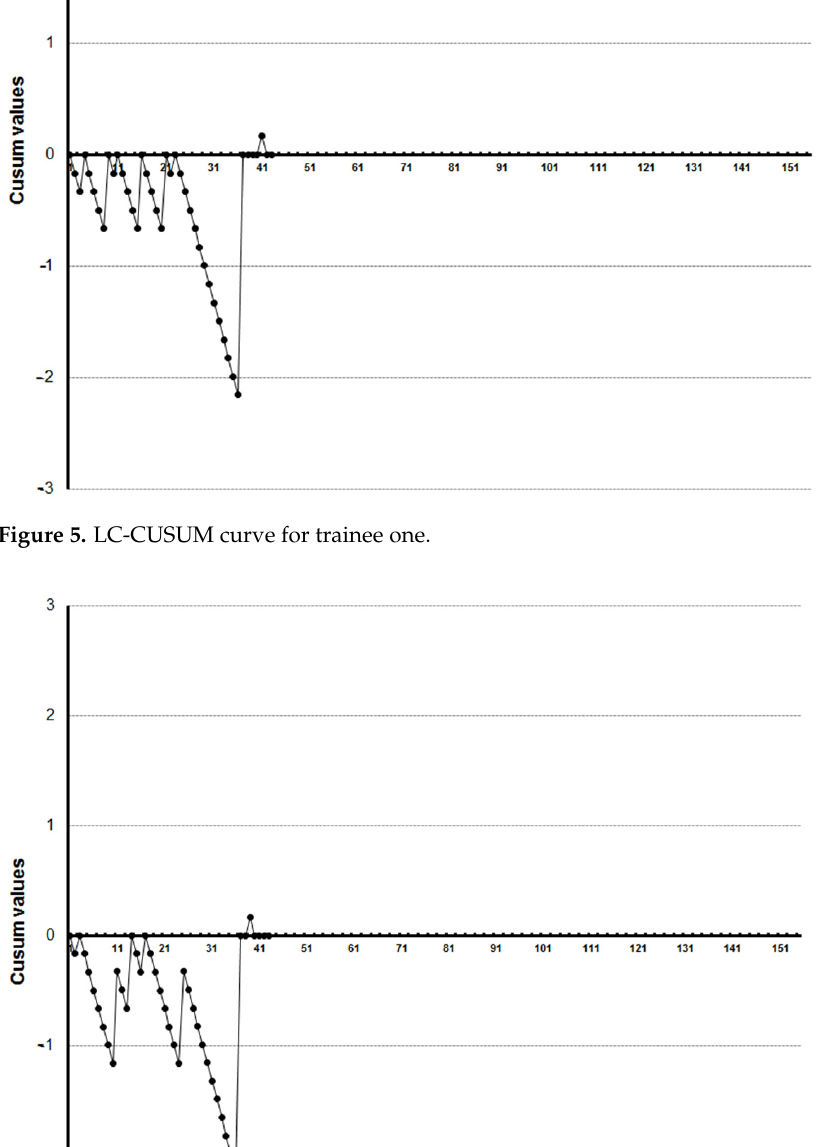
Figure 6. LC-CUSUM curve for trainee two.